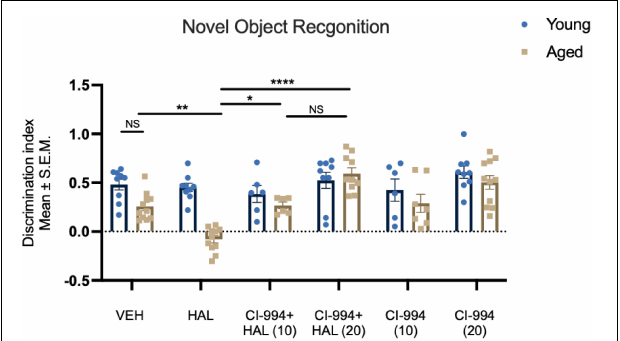
FIGURE 2 | CI-994 restores recognition memory impaired by HAL in aged mice. Aged mice did not display a decrease in recognition memory tested by NOR (VEH-aged vs VEH-young, p = 0.2752), however, HAL induced a memory impairment (aged HAL vs aged VEH, p = 0.0042). CI-994 at 10 and 20 mg/kg improved the memory function in a dose dependent manner (aged CI-994 10mg/kg + HAL vs aged HAL, p = 0.0249; aged CI-994 20 mg/kg + HAL vs. aged HAL, p < 0.0001). No significant difference between 10 mg/kg CI-994 + HAL and 20 mg/kg CI-994 + HAL groups ( p = 0.0576). Additionally, there was no difference between CI-994 alone and VEH groups in aged mice (aged CI-994 10 mg/kg vs. aged VEH, p > 0.9999; aged CI-994 20 mg/kg vs. aged VEH, p = 0.1109). Data represent mean ± SEM ( n = 6–11/per group). * p < 0.05, ** p < 0.01, **** p < 0.0001, NS, not